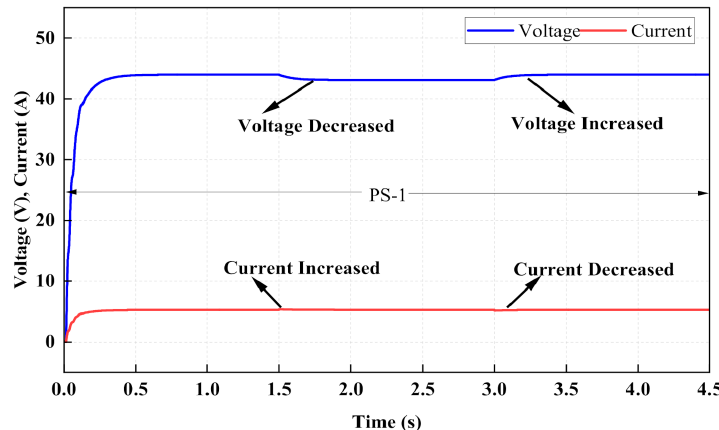
Figure 17. V-I characteristics during load variations.